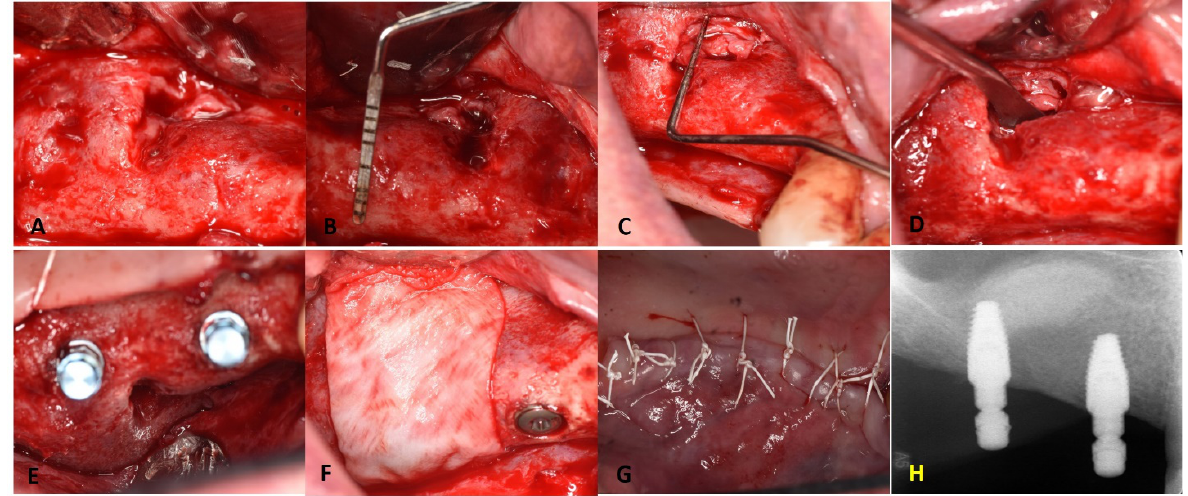
Figure 6. Surgical re-exposure for implant placement: ( A ) flap refection and exposure of previous